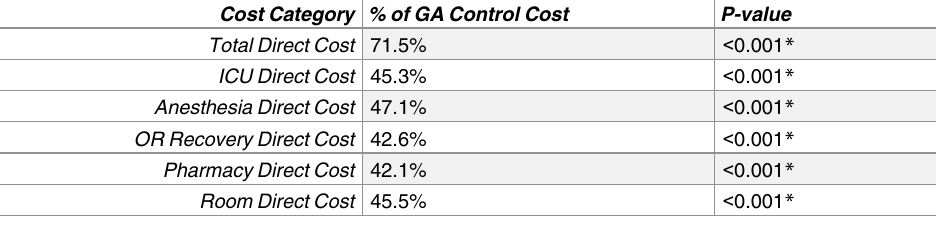
Table 3. Conscious sedation cost outcomes, all matched